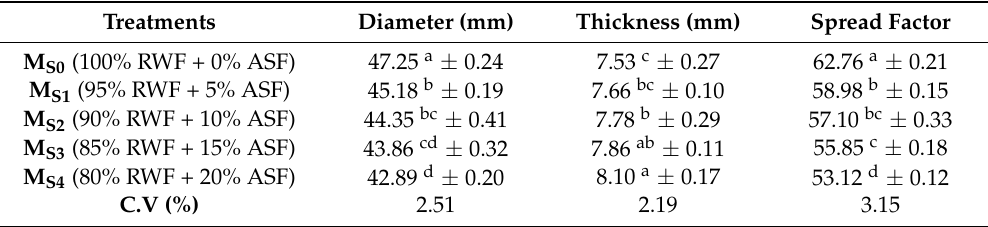
Table 3. Physical characteristics of control and supplemented